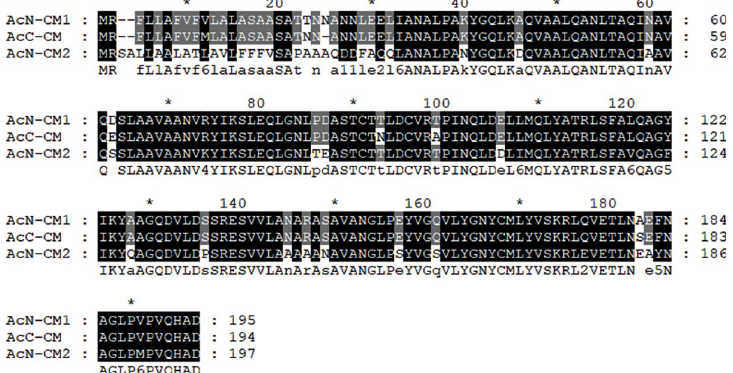
Fig 2. Alignment of the chorismate mutase amino acid sequences of Acanthamoeba spp.. Aligned amino acid sequences of A . castellanii Neff chorismate mutase 1 (ELR23397), A . castellanii Neff chorismate mutase 2 (ELR15898), and A . castellanii Castellani chorismate mutase (MN630520) were compared. ClustalX multiple sequence alignment was used to produce the alignment, and the degree of conservation is represented by different shading. AcN; Acanthamoeba castellanii Neff, AcC; Acanthamoeba castellanii Castellani, CM; chorismate mutase.